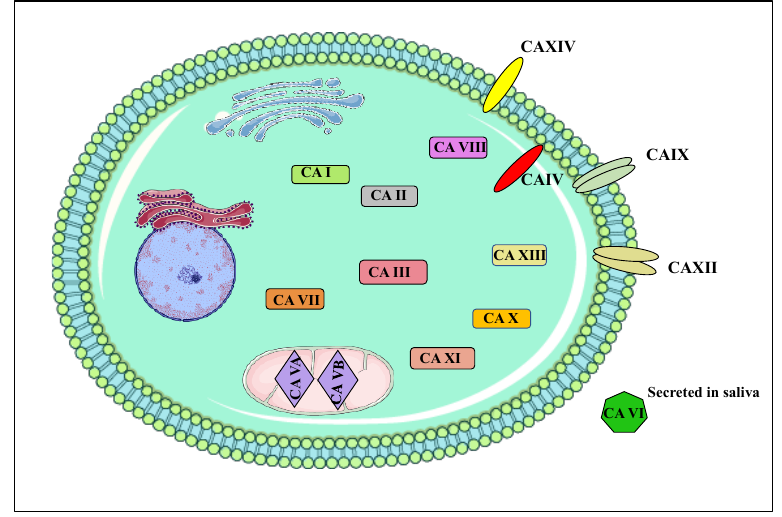
Figure 1. Subcellular localization of CAs. CA I, II, III, VII, VIII, X, XI and XIII are cytosolic; CA IX, XII, IV and XIV are membrane-bound; CA VA and VB are localized in mitochondria, and CA VI is